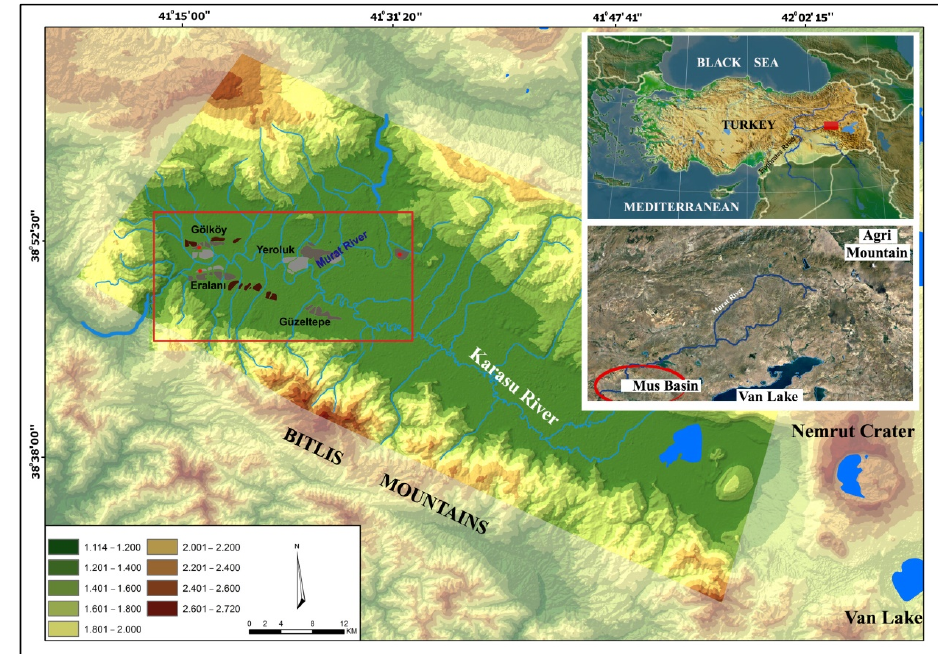
Figure 1. Location map of the study area.